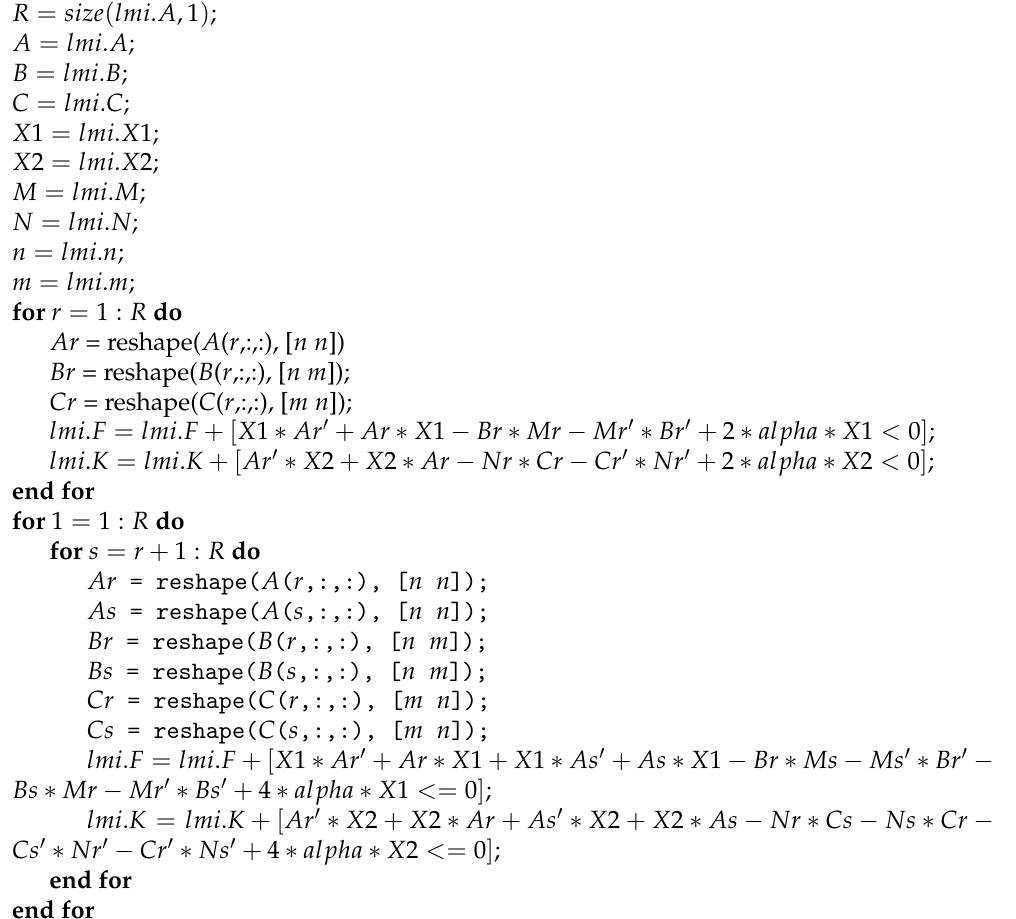
Algorithm 1 Asymptotically stable LMI-based controller and observer design with decay rate.